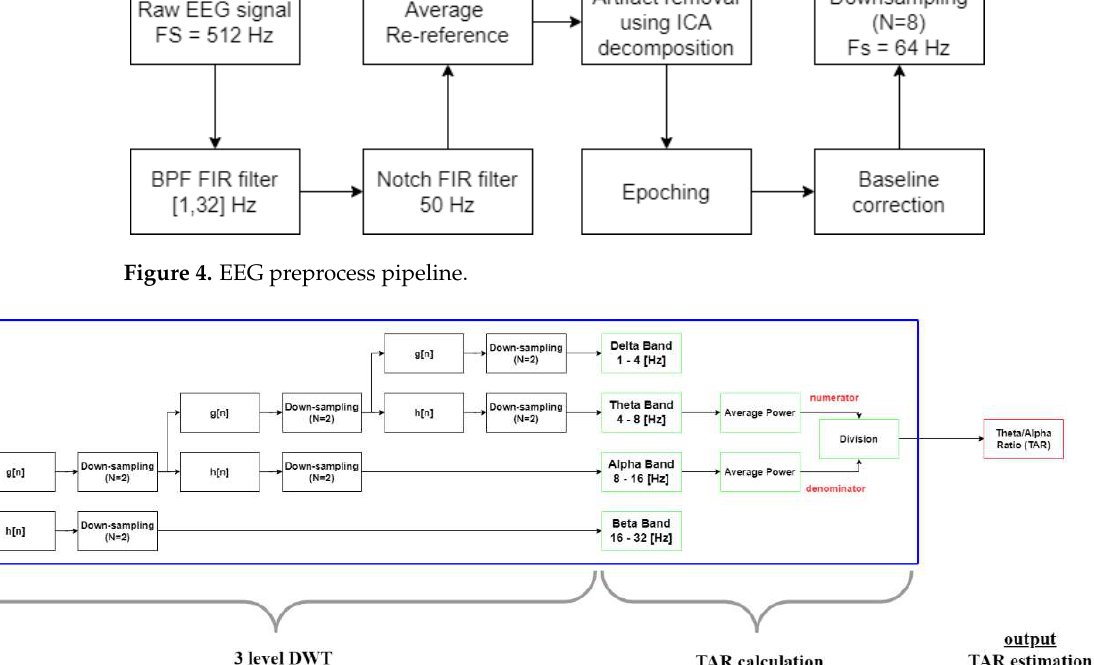
Figure 5. Theta-Alpha ratio calculation based on 3 level DWT scheme.